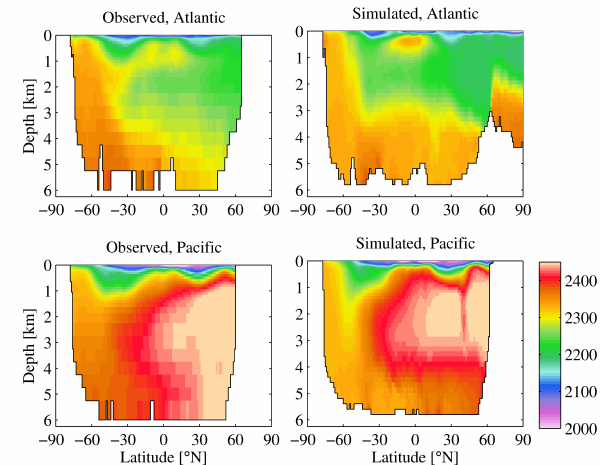
Fig. 17. Intercomparison of observational (left) and model (right) fields of zonally averaged dissolved inorganic carbon for the At- lantic (top) and Pacific (bottom) basins. Note that the GLODAP climatology has no values within the Arctic. Concentrations in mmolCm − 3 .